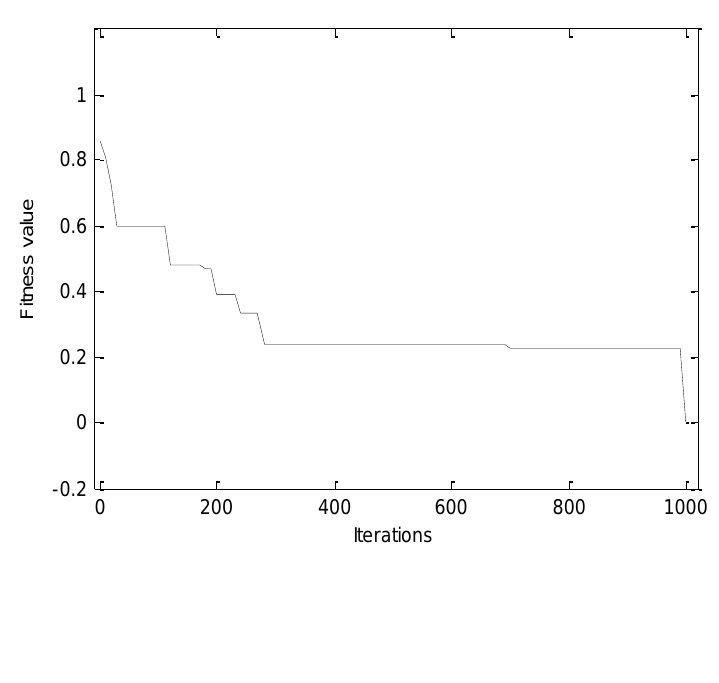
Figure 4. Convergence